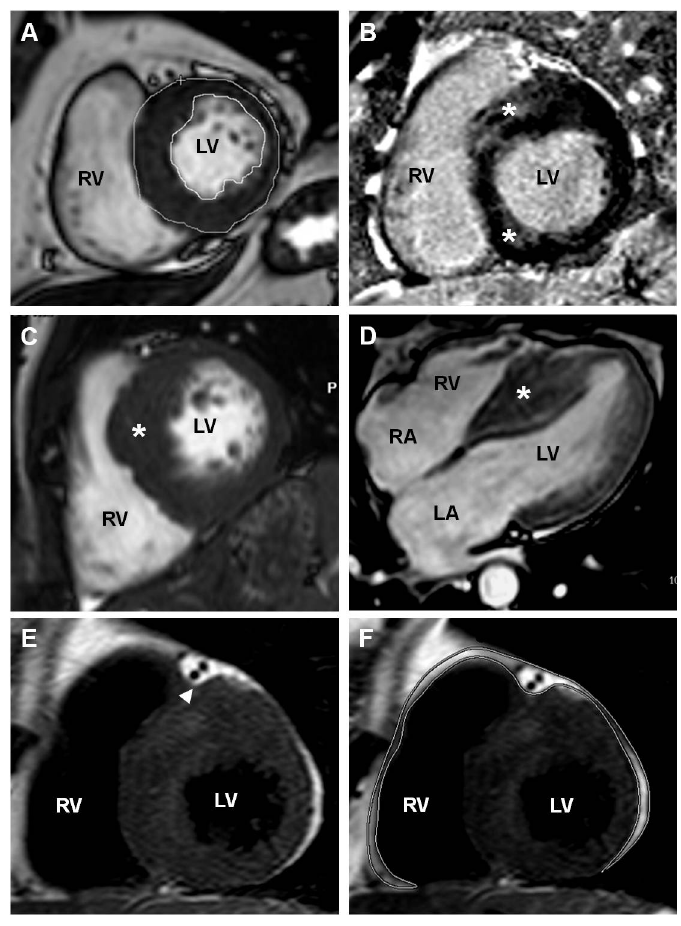
multifocal mid-wall distribution. (C-D) Asymmetric LV hypertrophy. CMR short axis (2-chamber) (C) and horizontal long axis (4-chamber) (D) view showing marked IVS thickening (asterisk); (E) EAT thickness measured at the anterior interventricular groove site (arrowhead). (F) Volumetric assessment of EAT. The contours of EAT were outlined in end-diastolic images of short-axis views covering the whole left and right ventricle. The areas obtained for each slice were added together and multiplied by slice thickness to yield EAT volume. Abbreviations: CMR, cardiac magnetic resonance; EAT, epicardial adipose tissue; HCM, Hypertrophic Cardiomyopathy; IVS, interventricular septum; LGE, late gadolinium enhancement; LV, left ventricle; RV, right